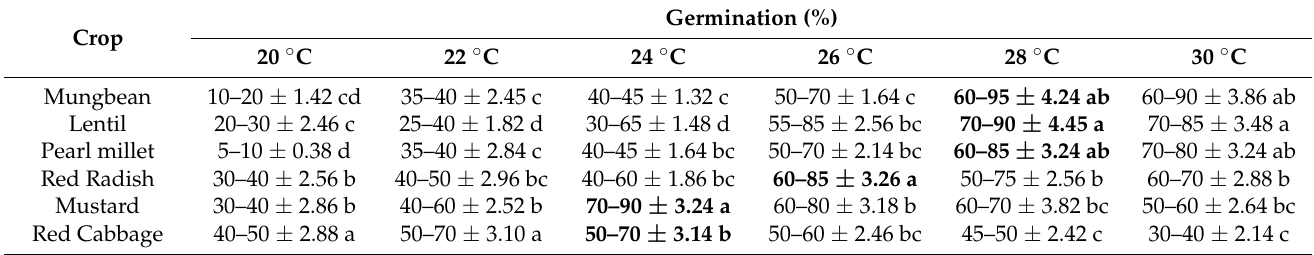
Table 4. Germination percentage of selected crops at different